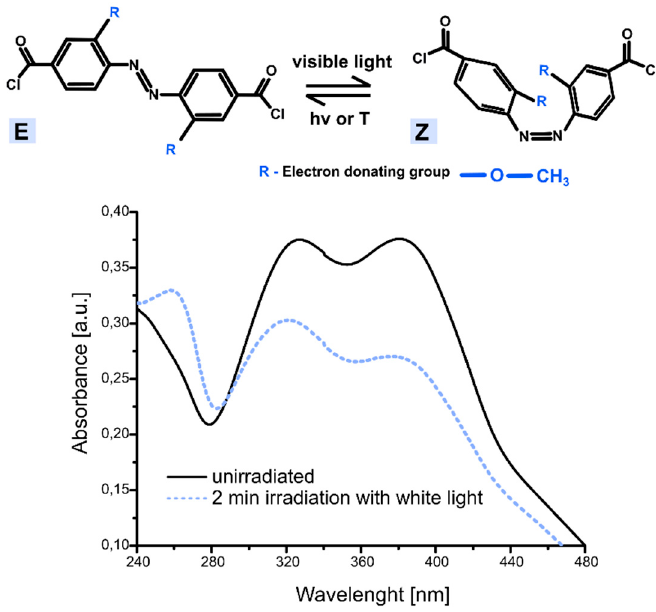
Figure 8. UV-VIS absorption spectra of ortho-substituted azobenzene at room temperature ( a ) before and ( b ) after 2 min irradiation with white light.